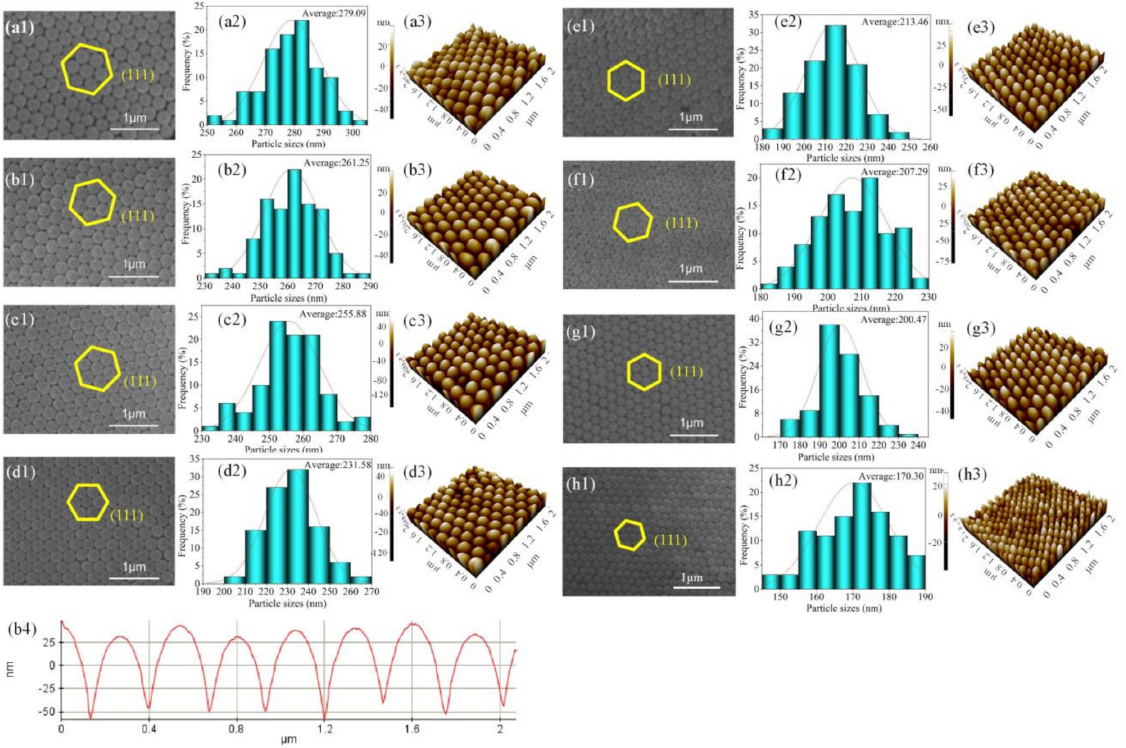
Figure 2. SiO 2 PCFs with SiO 2 NPs sizes ( a ) 294.0 nm, ( b ) 273.9 nm, ( c ) 267.3 nm, ( d ) 245.0 nm, ( e ) 229.9 nm, ( f ) 224.8 nm, ( g ) 216.0 nm, ( h ) 182.0 nm measured by Zeta Plus particle size analyser. ( a1 – h1 ) SEM micrographs of SiO 2 PCFs with honeycomb structures as shown in the areas of yellow frames (magnification: 80,000 × ). ( a2 – h2 ) histogram of corresponding particle size distribution with different average diameters measured by Nano Measurer software: 279.09 nm, 261.25 nm, 255.88 nm, 231.58 nm, 213.46 nm, 207.29 nm, 200.47 nm, 170.30 nm. The red lines were the curves obtained by Gaussian fitting. ( a3 – h3 ) Three-dimensional (3-D) representations of surface morphology of SiO 2 NPs measured by AFM showing within close-packed hexagonal cone structures. The measured area is 2 × 2 µ m 2 . ( b4 ) Section analysis of SiO 2 NPs (273.9 nm) by atomic force microscopy